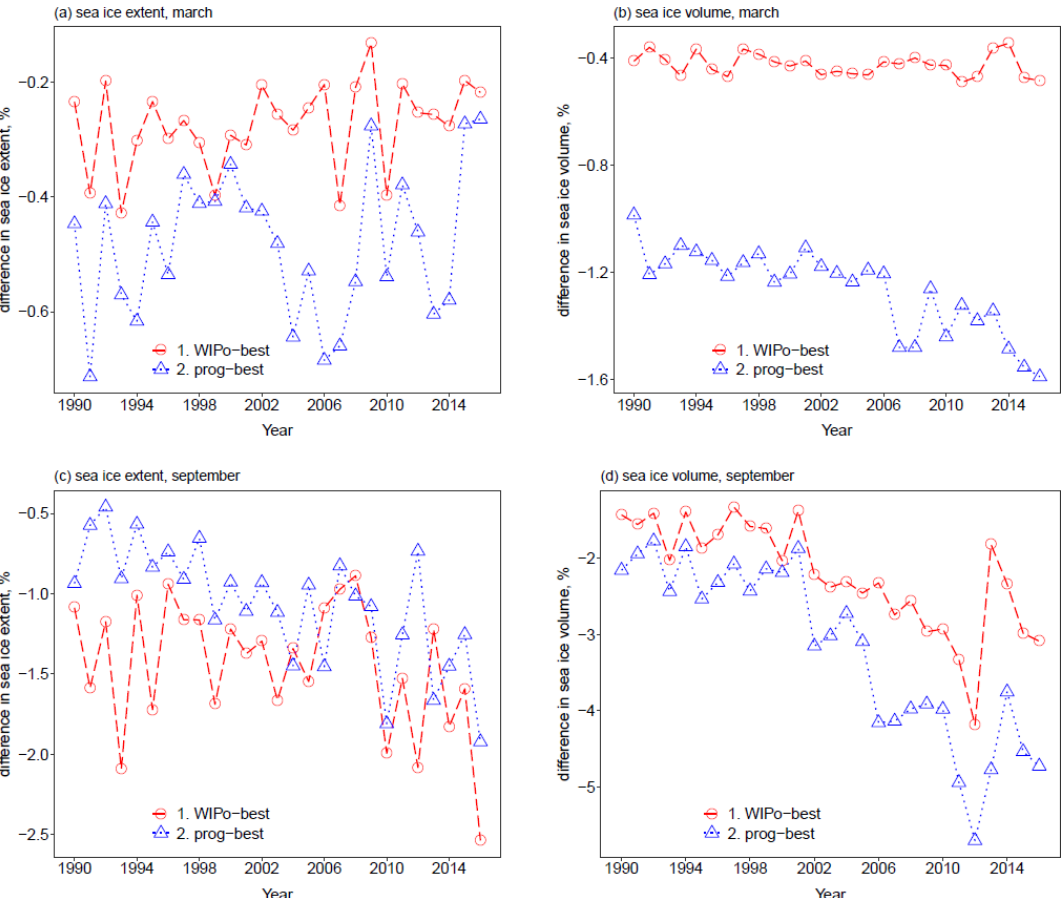
Figure 8. The percent difference in total sea ice March extent (a) , March volume (b) , September extent (c) , and September volume (d) in the Arctic over the period 1990–2016 for WIPo-best (red, circles, dashed) and prog-best (blue, triangles, dotted) relative to